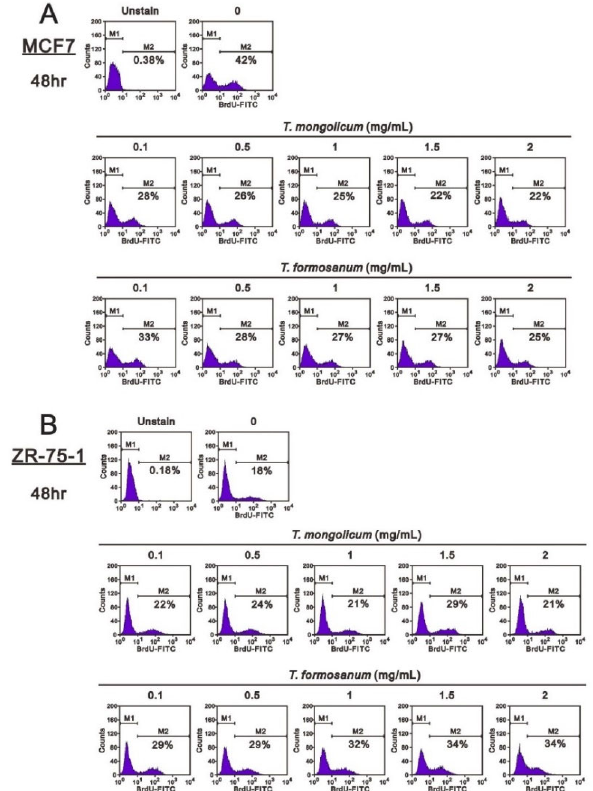
Figure 11. Effects of T. mongolicum and T. formosanum on cell proliferation in MCF ‐ 7 and ZR ‐ 75 ‐ 1 cells. ( A ) MCF ‐ 7 and ( B ) ZR ‐ 75 ‐ 1 cells were treated for 48 h with the indicated concentrations of T. mongolicum or T. formosanum . They were then subjected to BrdU proliferation analysis. In MCF ‐ 7 and ZR ‐ 75 ‐ 1 cells, T. mongolicum and T. formosanum both significantly de ‐ creased colony formation (Figure 12) and cell migration in a dose ‐ dependent manner (Fig ‐ ure 12). The suppressive effects of cell migration by T. mongolicum and T. formosanum were better in ZR ‐ 75 ‐ 1 cells than in MCF ‐ 7 cells.